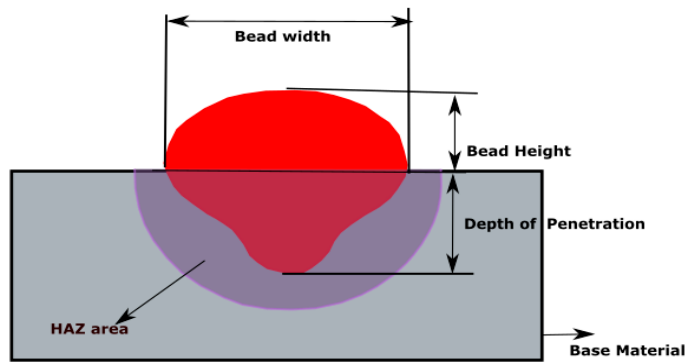
ff ected zone (HAZ) area